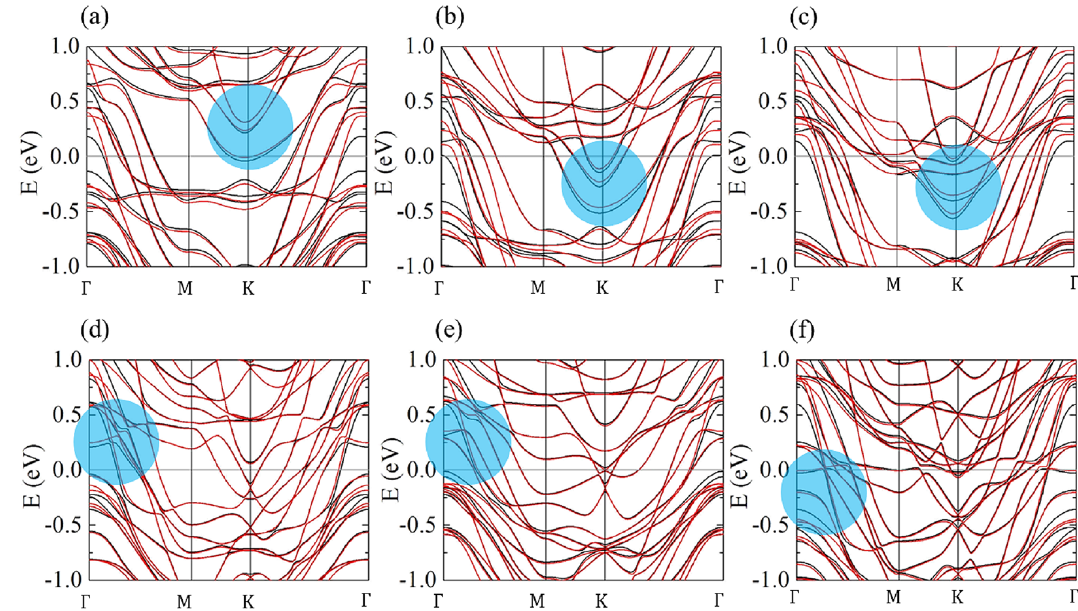
Figure 5. Band structures of FGT with spin direction along 001 denoted by black and 100 denoted by red colour. ( a – c ) show the case of Fe 3 GeTe 2 with doping of − 0.3, 0 and 0.3 electrons per Fe atom, respectively. ( d – f ) show the case of Fe 4 GeTe 2 with doping of − 0.3, 0 and 0.3 electrons per Fe atom,